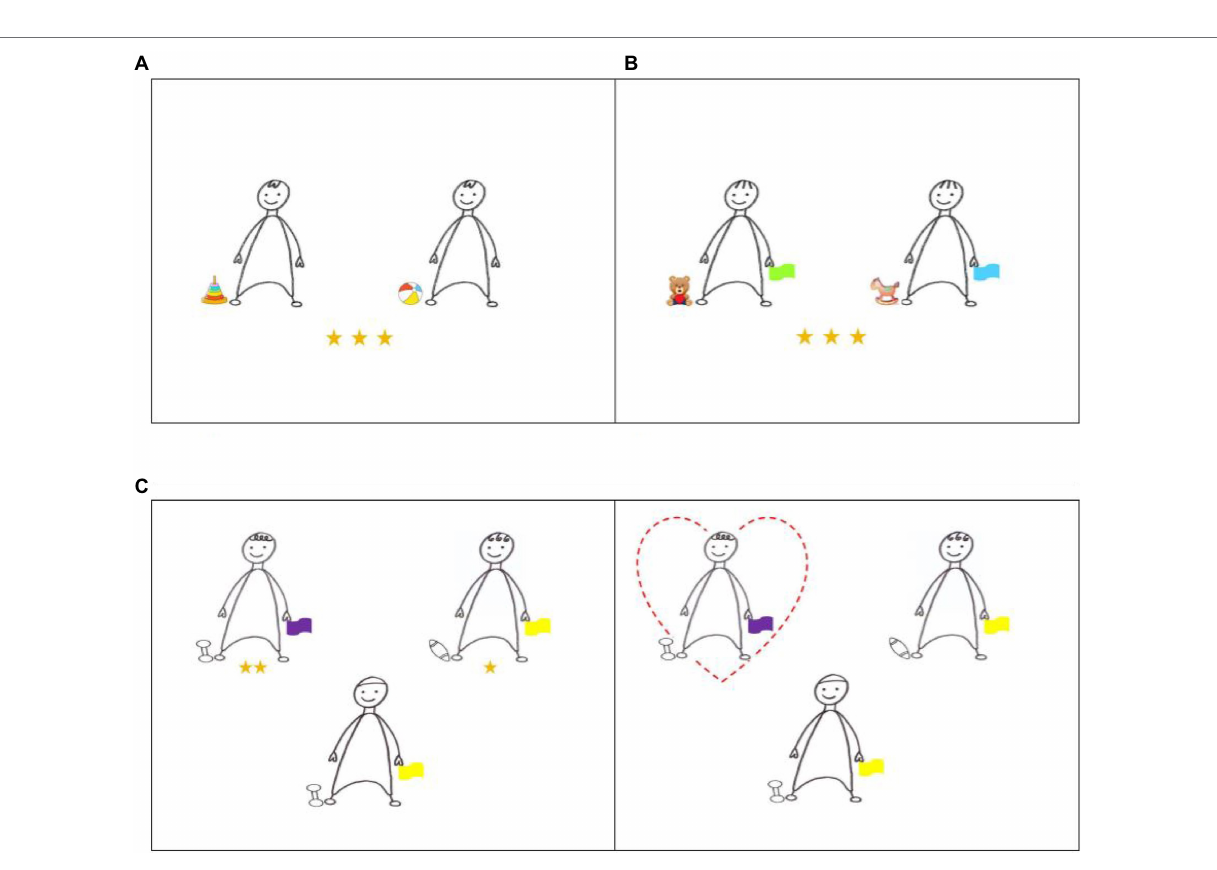
FIGURE 2 | Sample items of Tasks 1 (A) , 2 (B) , and 3 (C) . The images of toys and animals used in task 1 and 2 were obtained from the following free image websites (www.huihua8.com; www.jianbihua.com; www.51yuansu.com; www.baiqi008.com; www.jbhdq.com;